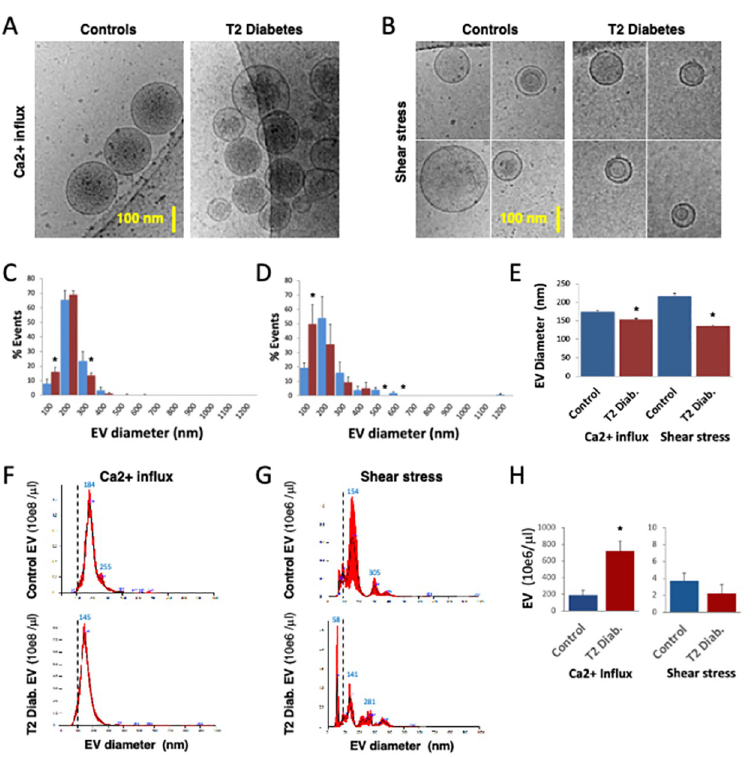
Fig 2. RBC from patients with type 2 diabetes release abnormal EV. Purified RBC from control (Blue) or obese T2D (Red) patient blood (n = 4) were stressed by sudden addition of Ca 2+ ionophore (A23187) (A, C, F) , or application of shear stress (Dounce homogenizer strokes) (B, D, G) . Supernatants were collected and analyzed by cryogenic, transmission electron microscopy (CryoTEM) (A-E) , or nanoparticle tracking analysis (NTA) (F-H) . EV size distributions were computed in categories of 100 nm increment (C, D) , and considered ‘small’ below 100 nm in diameter (interrupted bars). Average EV sizes were compared according to parental RBC (Controls, T2D) and type of vesiculation (E, H) . EV size distributions (F, G) and concentrations were assessed by NTA (H) . T2D RBC-derived EV were 12% to 37% smaller in diameter than control EV, with a 2-fold increase in the prevalence of small EV ( < 100 nm). NTA also showed that T2D RBC stimulated by Ca 2+ influx shed 3-fold more EV than control RBC. In general, Ca 2+ influx triggered 50 to 300-fold more EV than shear stress. ( � ) p < 0.05 vs.